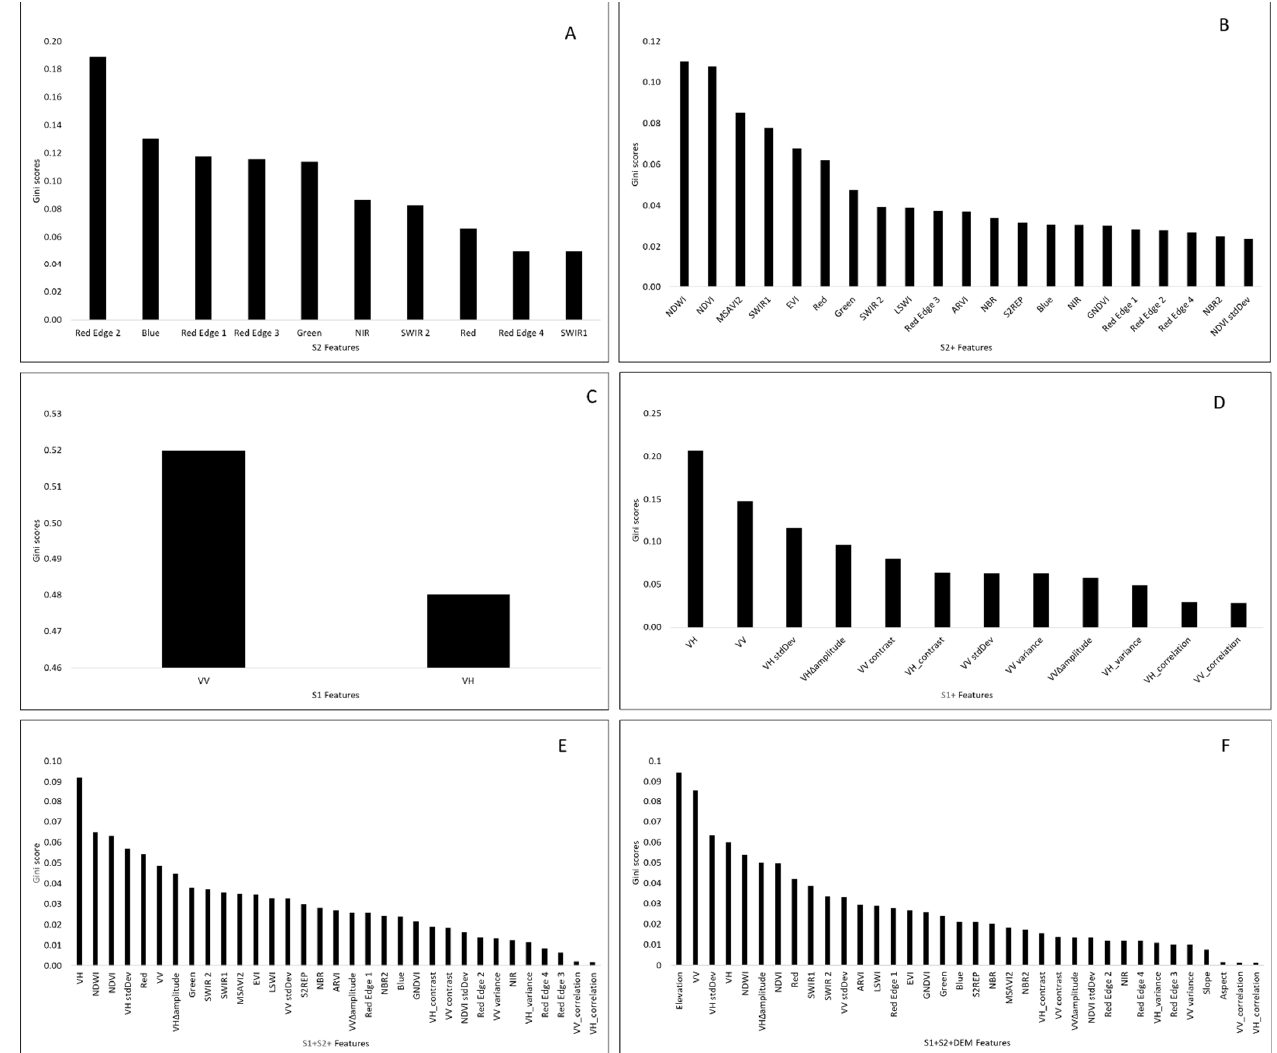
Figure 7. Important predictor variables from RF classification results: (a) S2, (b) S2+, (c) S1, (d) S1+, (e) S2+S1+ and (f) S2+S1+DEM.